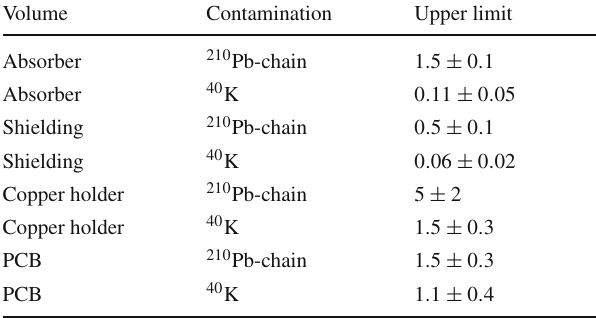
Table 7 Necessary activity concentration in mBqcm − 2 for a count rate due to radionuclides equal to the unresolved pile-up count rate in the ROI Volume